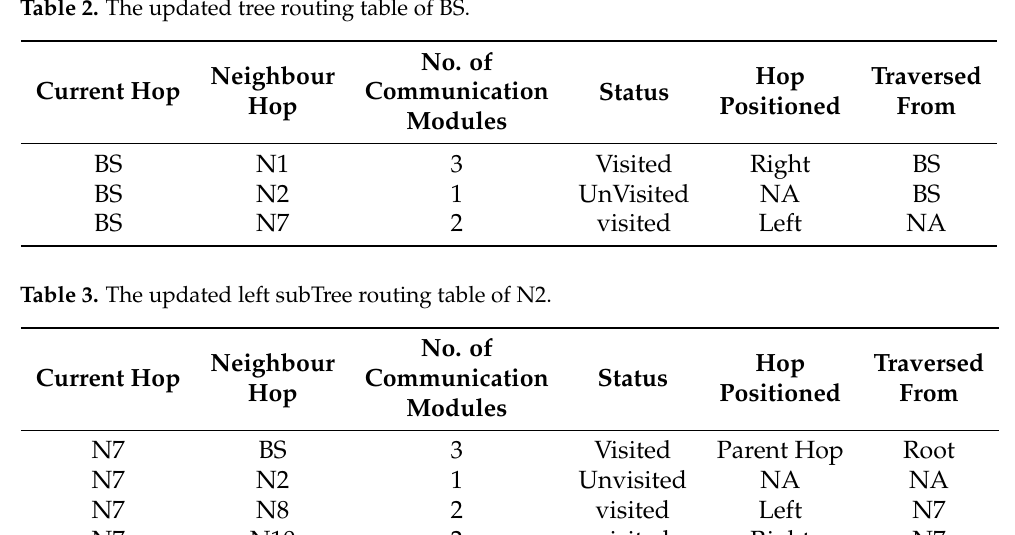
Table 2. The updated tree routing table of BS.